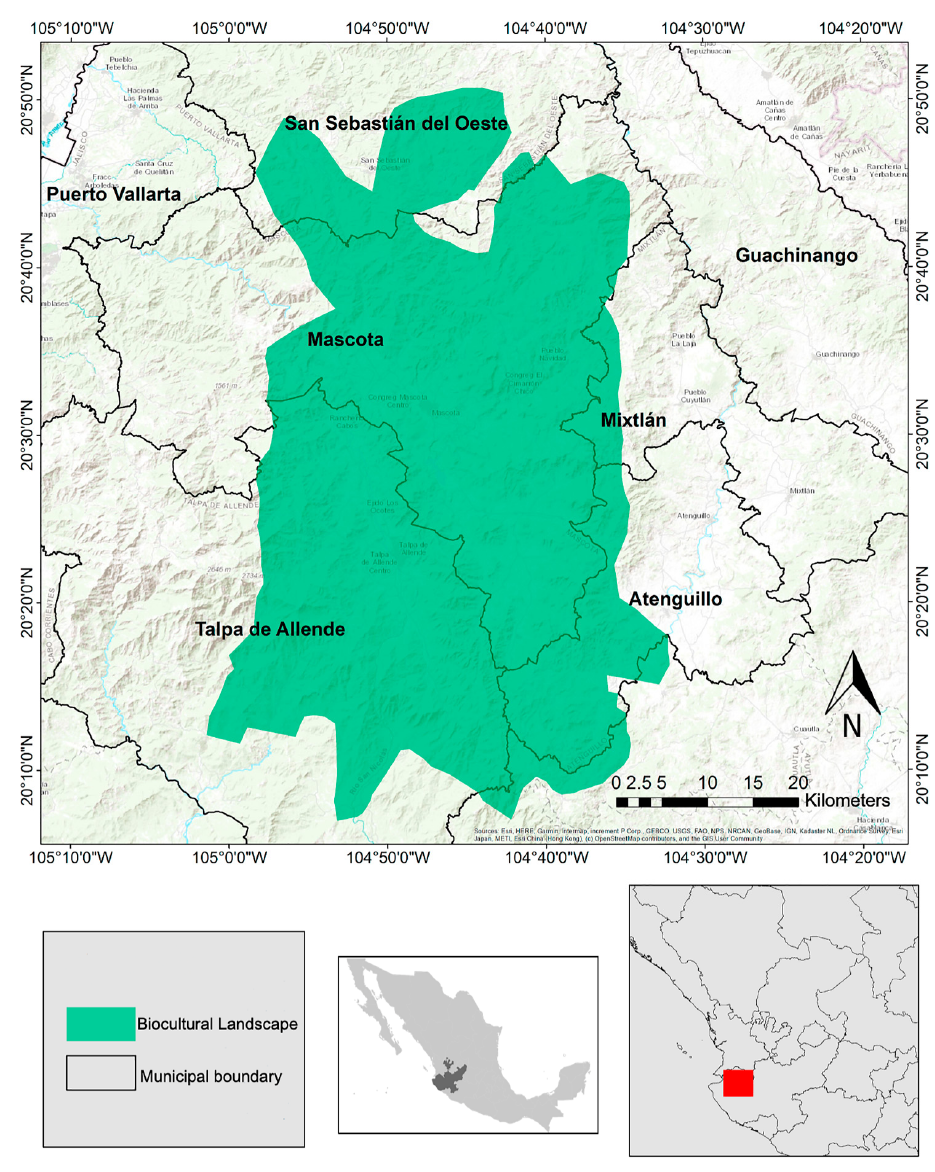
Figure 1. Geographical location of the Biocultural Landscape area at Western Sierra (in red) of Jalisco (in